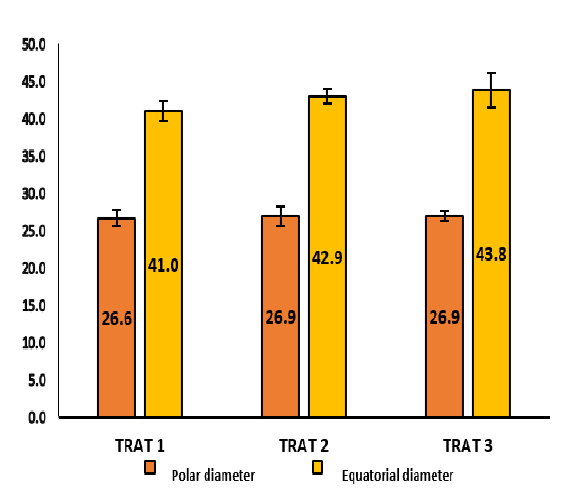
Figure 4. Effect of fertilisation method on garlic bulb size (mm) in cv. ‘Margosino’. All values are means ± SE (n = 10).